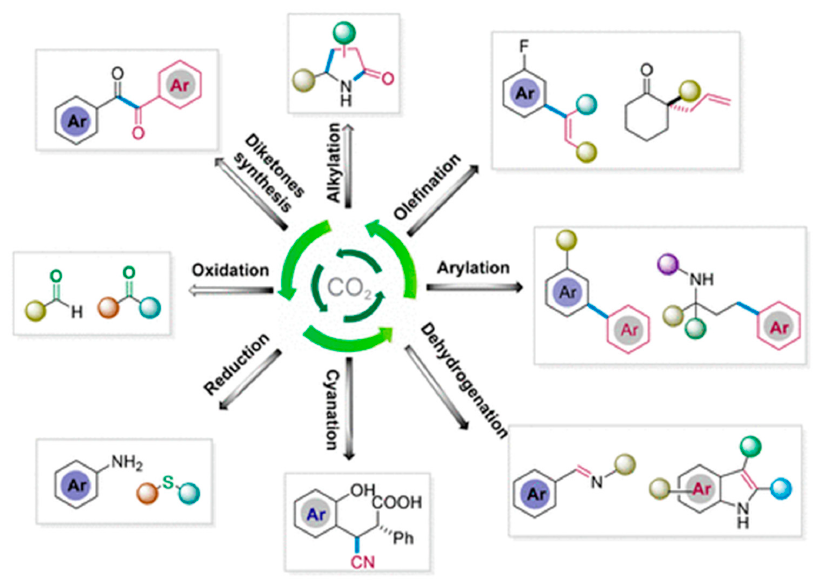
Figure 1. CO 2 -Promoted Reactions for the Synthesis of Fine Chemicals and Pharmaceuticals. Reproduced with permission from the author [6]. Copyright © 2021, American Chemical Society.